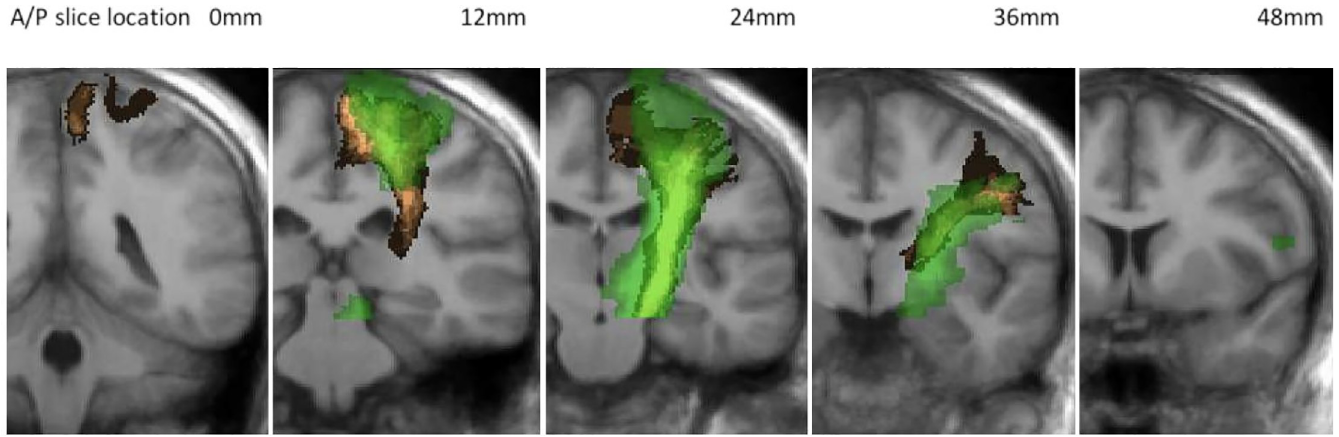
Fig 8. Tractography of the CST generated with the inclusion of a precentral gyrus waypoint ROI. Green: CST frequency map in standard space for Prob 0.025. Copper: CST defined in the Ju¨lich atlas. Images are overlaid on the average structural image for all 10 volunteer subjects.